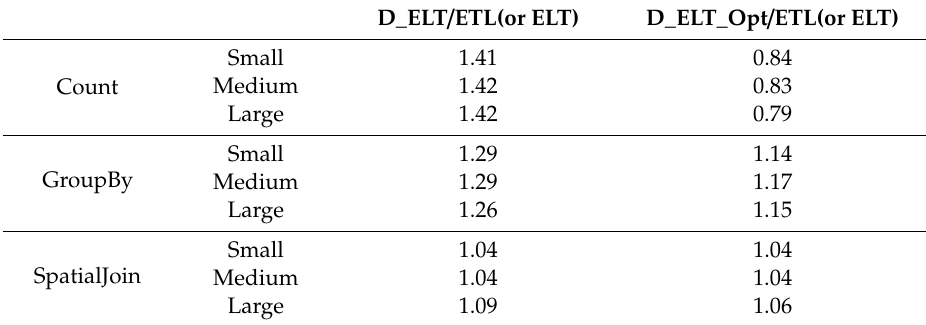
Table 4. Performance comparison: D_ELT/ETL(or ELT) and optimized D_ELT/ETL(or ELT).